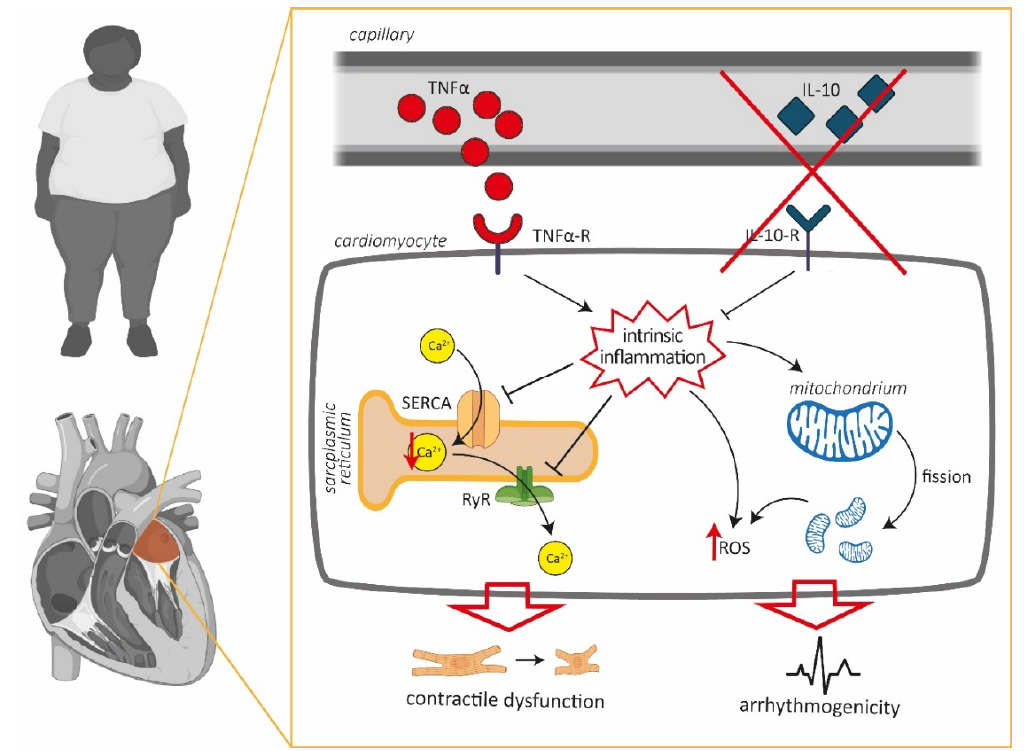
Figure 6. Proposed effect of dysfunctional TNFα/IL-10 signaling in cardiomyocytes during metabolic HFpEF-related left atrial cardiomyopathy. Intrinsic inflammation mediates impairment of cellular Ca 2+ homeostasis and facilitates enhanced production of reactive oxygen species (ROS).